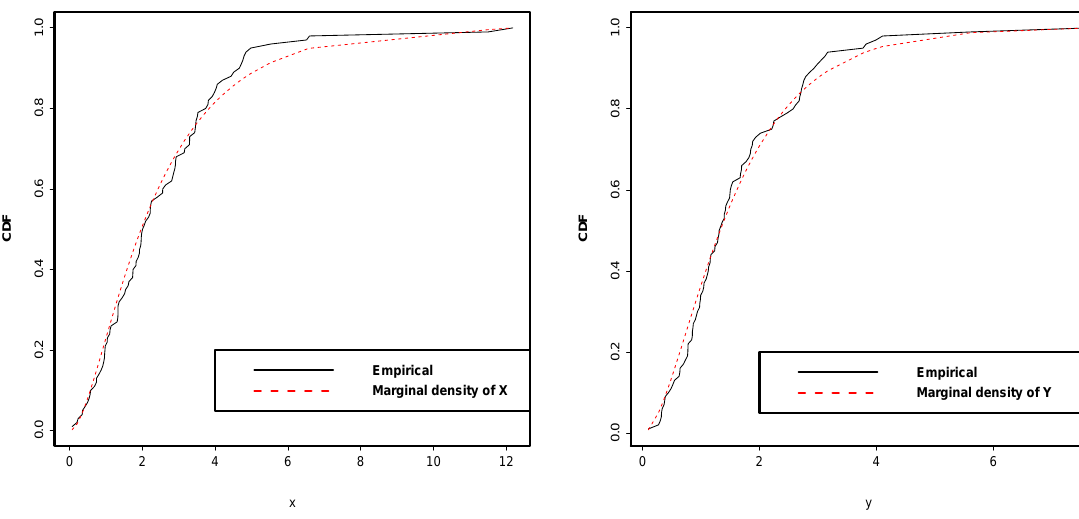
Figure A19. The scatter plot for the first data set.